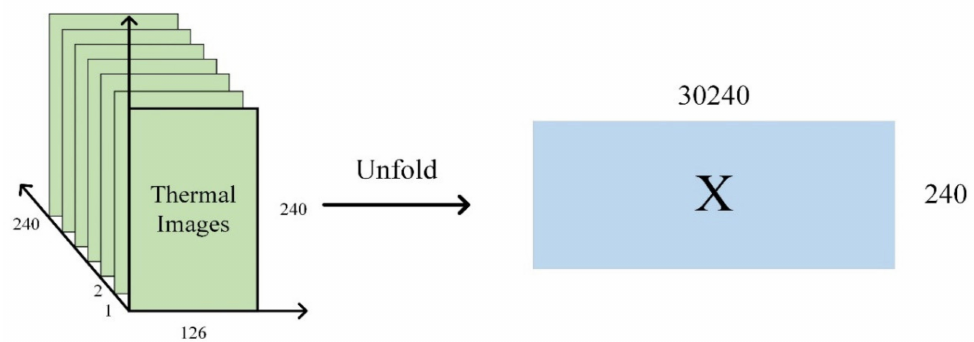
Figure 10. Unfolding the 3D matrix into 2D.